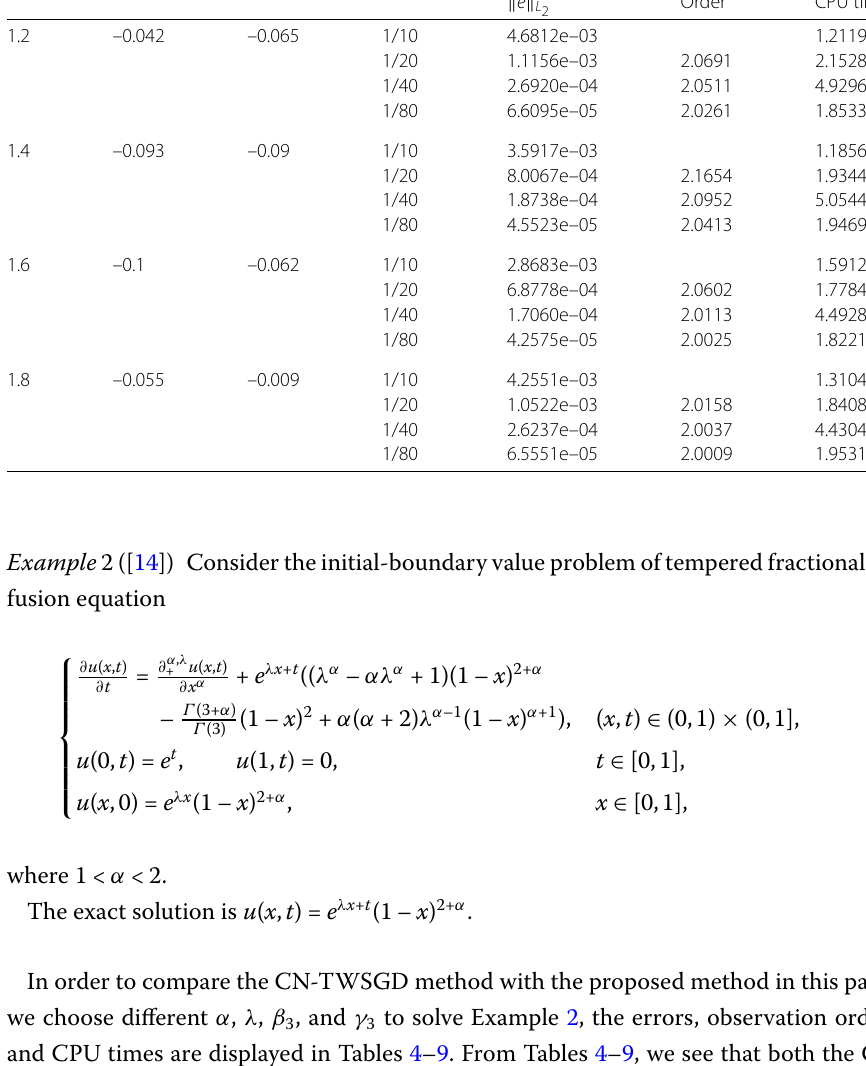
Table 4 Errors and corresponding observation orders at t = 1, λ = 1/50 α β